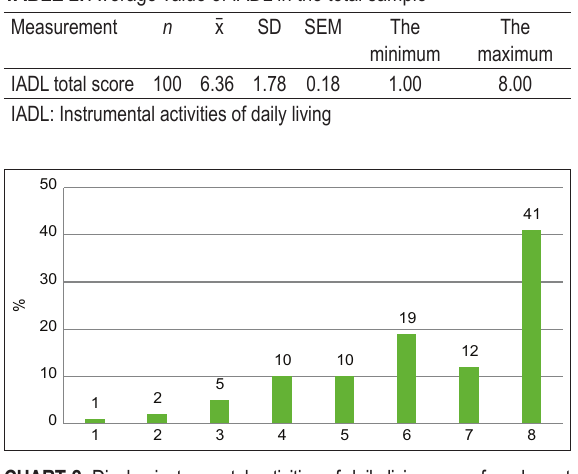
minimum maximum